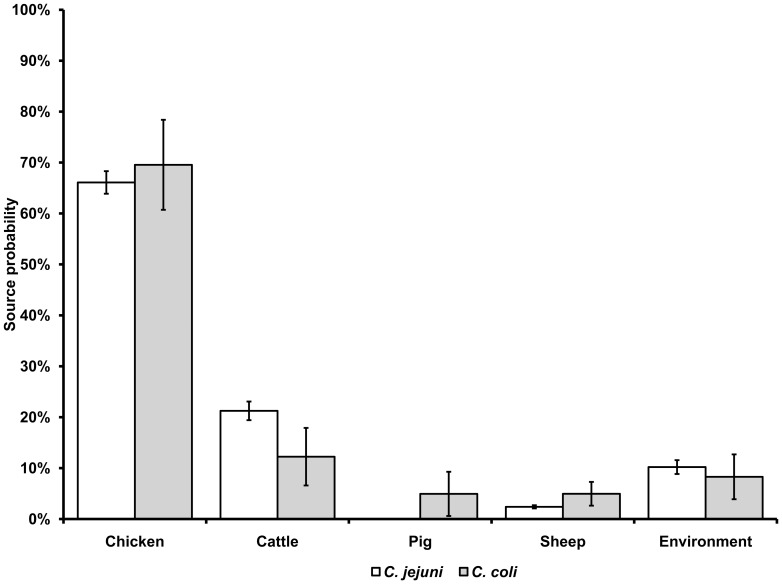
Overall mean probability (%) and 95% confidence interval for human C. jejuni (n = 696) and C. coli (n = 41) infections to originate from chicken, cattle, pig, sheep, and the environment.